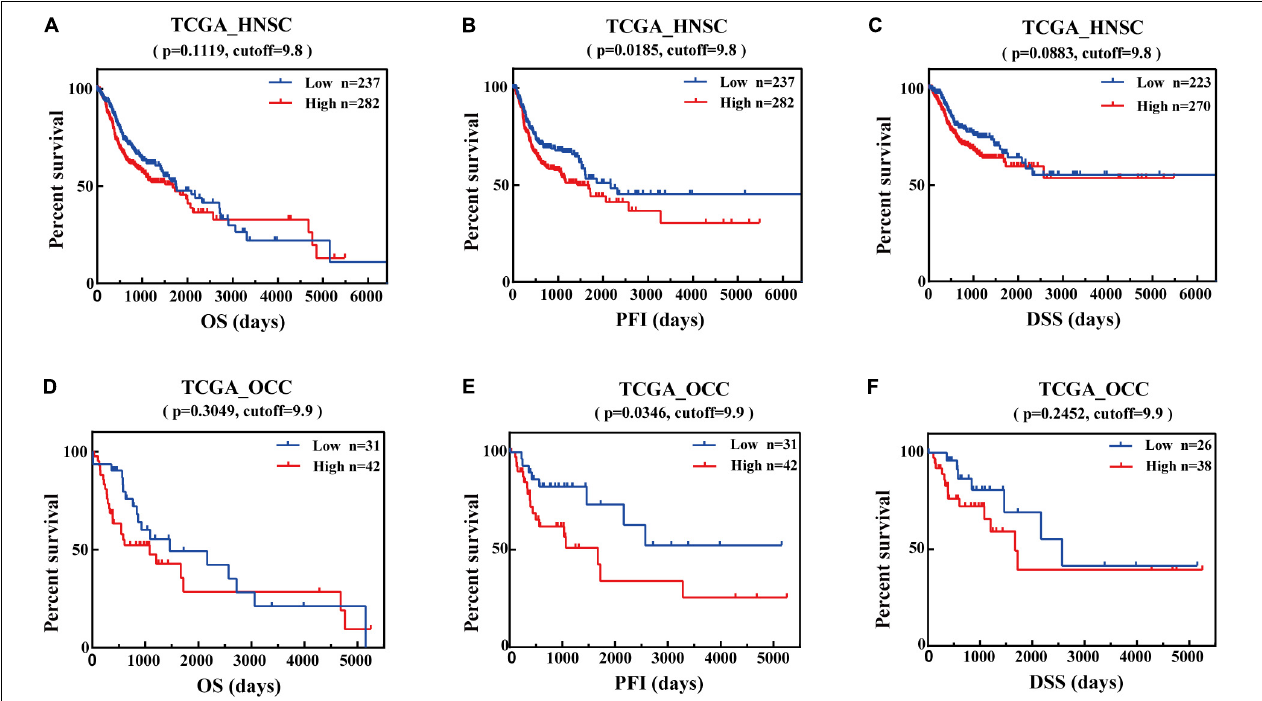
FIGURE 2 | The prognostic potential value of IFI44 in head and neck squamous cell carcinoma (HNSC). (A) Overall survival (OS), (B) progression-free interval (PFI), and (C) disease-specific survival (DSS) of two different expression levels of IFI44 in HNSC. (D) OS, (E) PFI, and (F) DSS of two different expression levels of IFI44 in oral cavity carcinoma